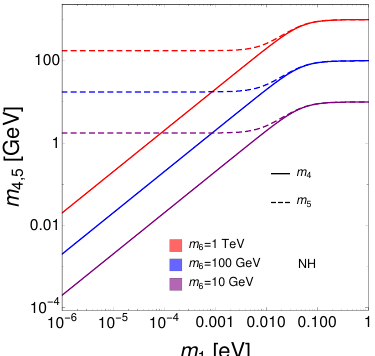
Figure 1. Sterile neutrino masses m 4 (solid) and m 5 (dashed) as a function of the lightest neutrino mass m for the heaviest neutrino mass m 1 the NH.